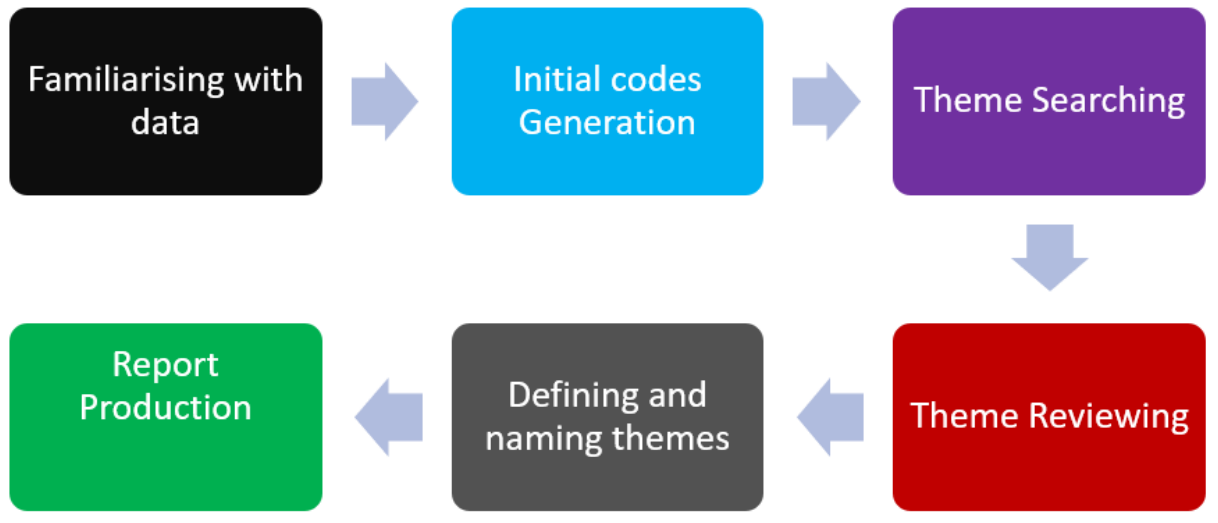
Figure 2. Steps and procedures followed during content analysis. Source: Authors.